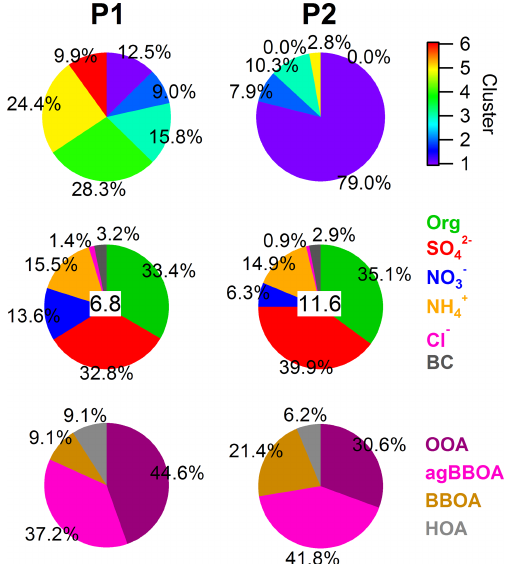
Figure 8. (a) The occurrence frequency of six air mass trajectory clusters, (b) average contributions of PM 1 chemical species to total PM 1 and (c) average contributions of four organic components to total organics during P1 and P2,